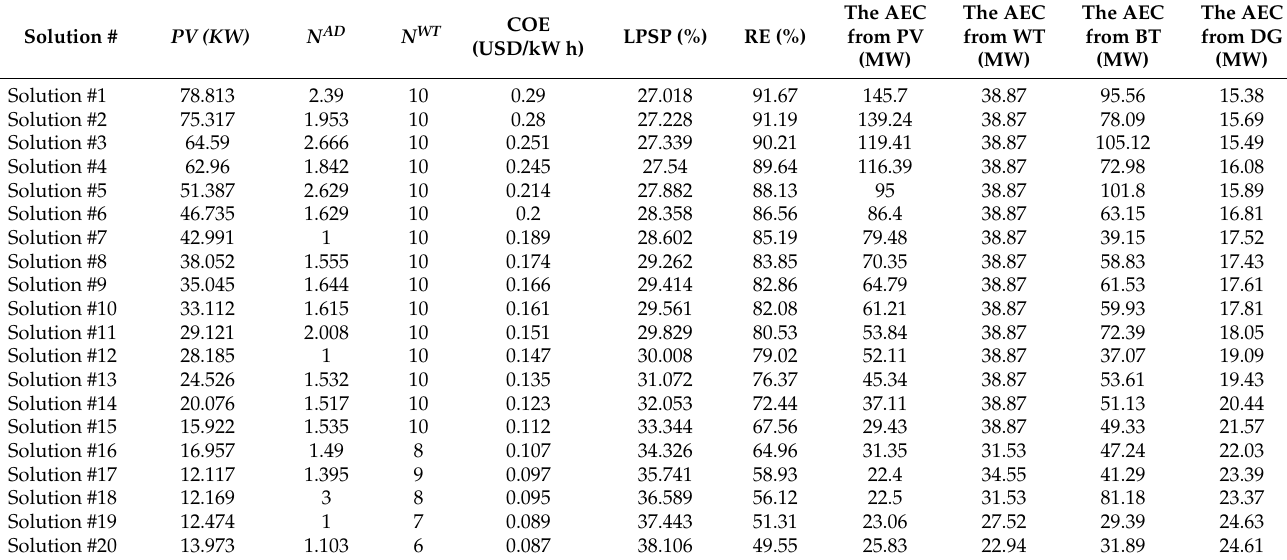
Table 9. Selected solutions from the Pareto front of MOALO.